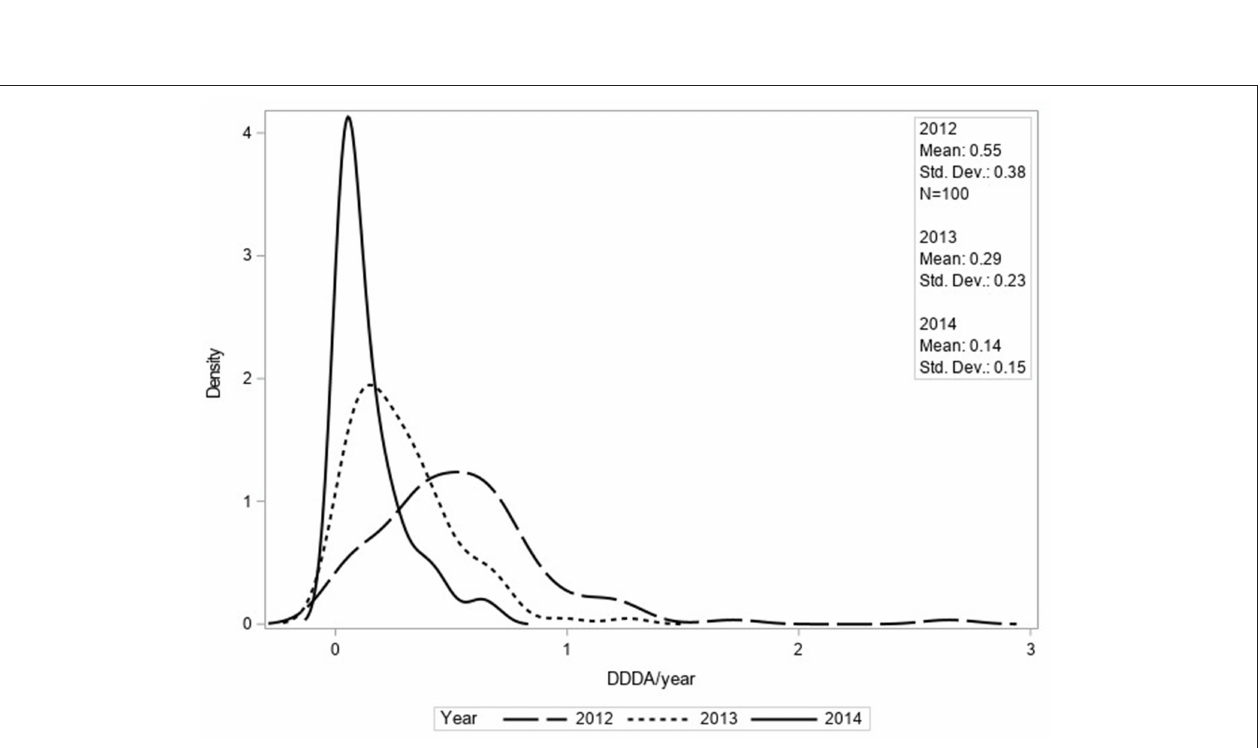
Frontiers in Veterinary Science | www.frontiersin.org